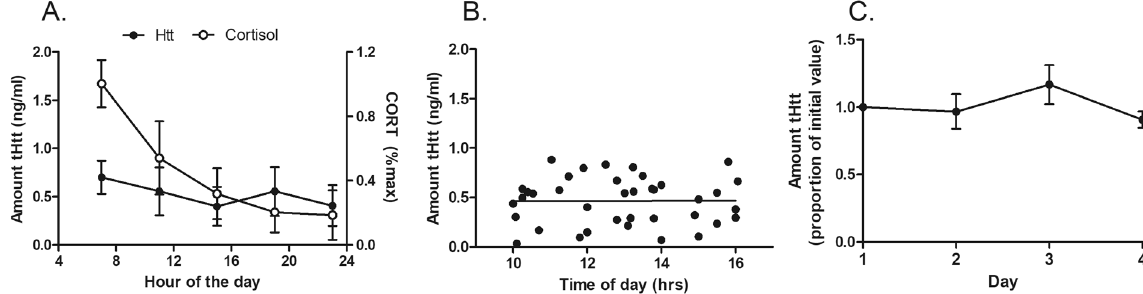
Figure 2. Diurnal stability and reproducibility of salivary tHtt levels. ( A ) Levels of tHtt were measured using ELISA in normal individuals over the course of the day and show no diurnal variation. For comparison, cortisol levels were measured using immunoassays from the same individuals at the same time points. The amount of tHtt reported is relative to a recombinant Htt protein standard corresponded to amino acids 802–940 of the human Htt protein. Data represent the mean + / − S.E.M value from n = 5 individuals. ( B ) Salivary levels of tHtt do not vary over the time of sample collection (10 am to 4 pm) in HD patients. Data represent the mean + / − S.E.M value from n = 40 patients. ( C ) Salivary tHtt is reproducibly detected on different days. Data shows tHtt measures taken on four non-consecutive days from the same individuals (n = 8).